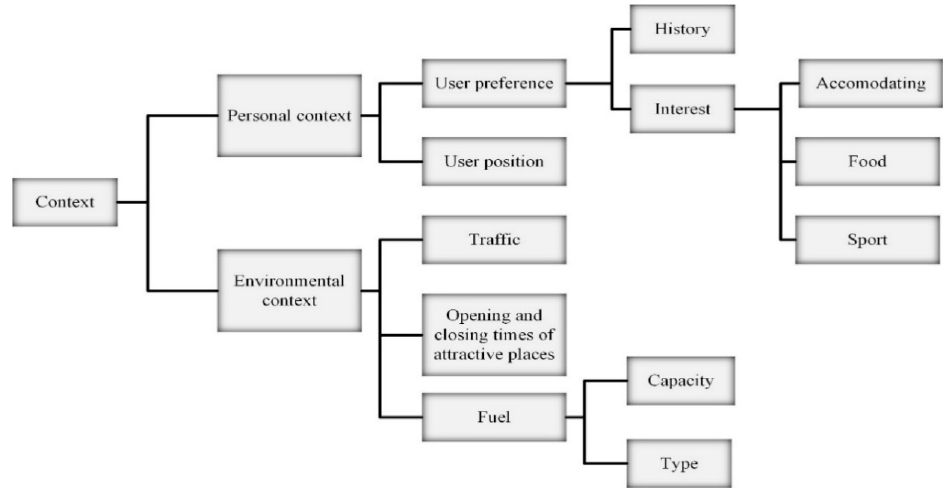
Figure 3. Context-related information.